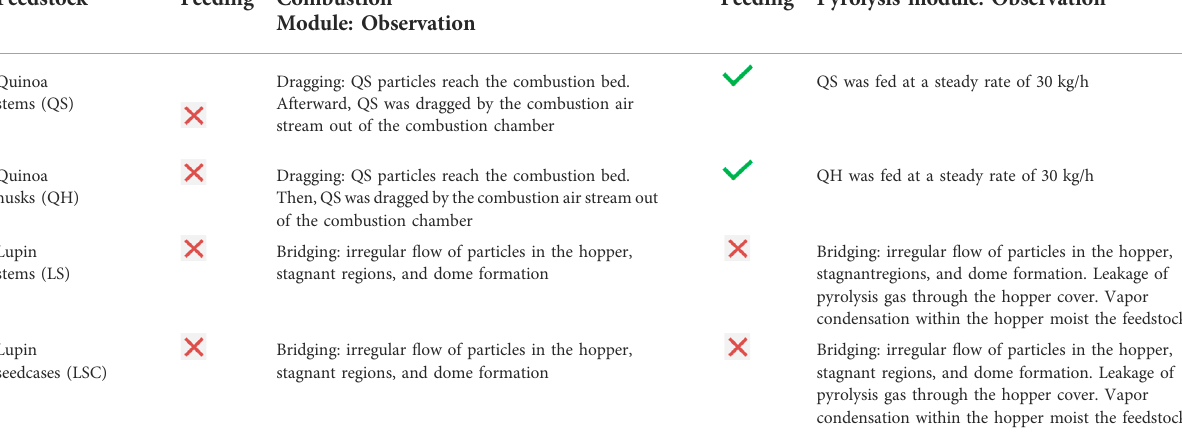
TABLE 2 Observations made during the conveying process of QH, QS, LS and LSC from the hopper of the combustion module towards the combustion bed and from the pyrolysis module hopper towards the carbonization chamber. Feedstock Feeding Combustion Feeding Pyrolysis module: Module: Observation